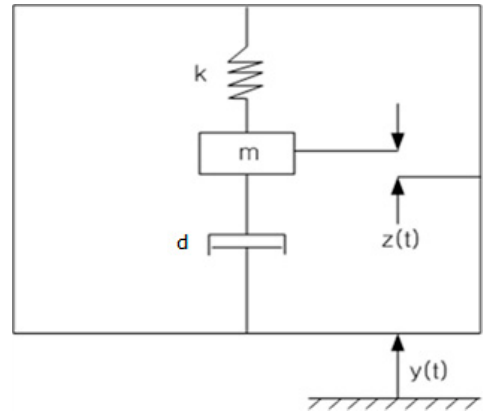
Figure 10. A schematic diagram of the vibration energy harvester based on a resonant mass-spring-